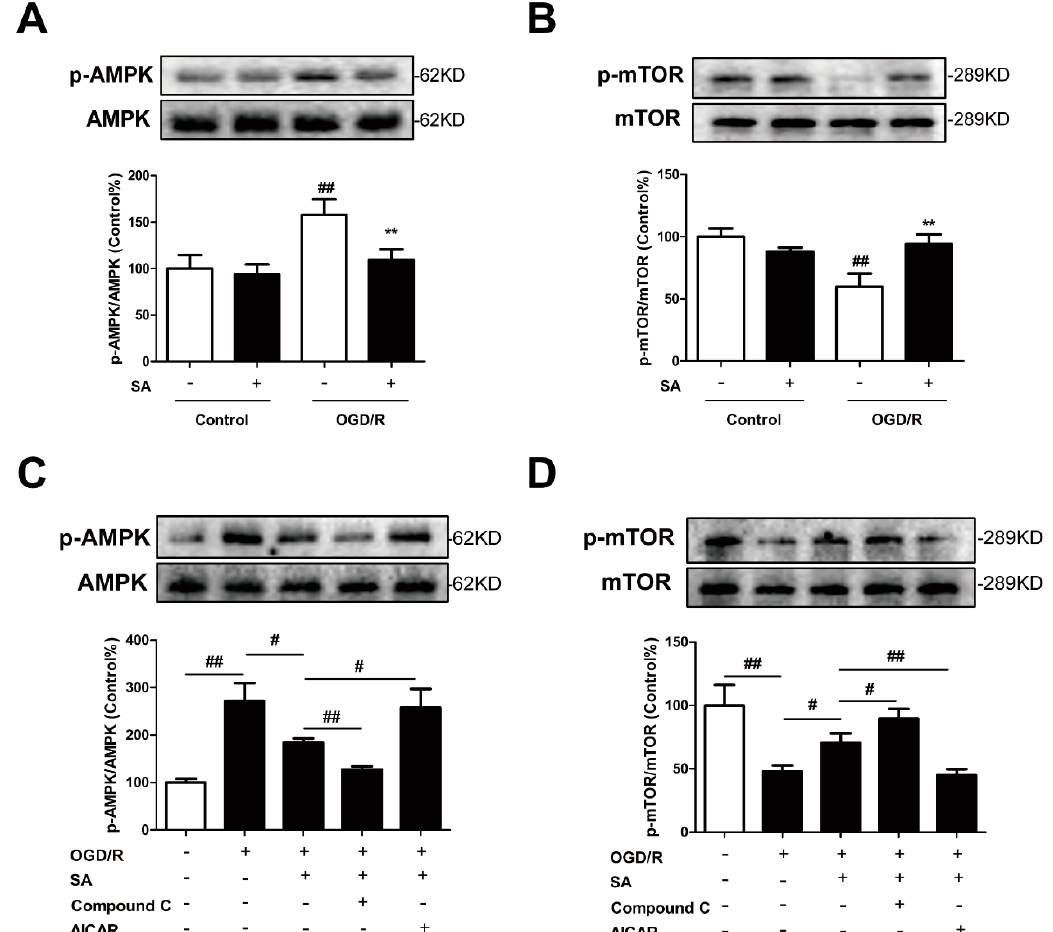
Figure 5. SA modulated AMPK/mTOR pathway proteins in PC12 cells. PC12 cells were pretreated with SA and exposed to OGD/R. The expression of phosphorylation of AMPK ( A ) and mTOR ( B ) was detected by Western blot (n = 3). All data are mean ± SD. ## P < 0.01 vs. control group; ** P < 0.01 vs. model group. PC12 cells were treated with SA (10 μ M) and 1 μ M compound C or 1 mM AICAR and then exposed to OGD/R. The expression of phosphorylation of AMPK ( C ) and mTOR ( D ) was detected by Western blot (n = 3). All data are mean ± SD. # P < 0.05 and ## P < 0.01.